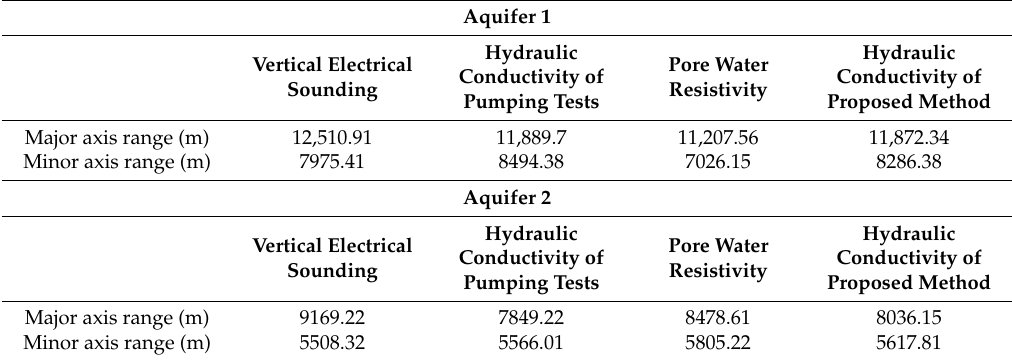
Table 1. Variogram fitting results for vertical electrical sounding, pore water resistivity, and hydraulic conductivity.